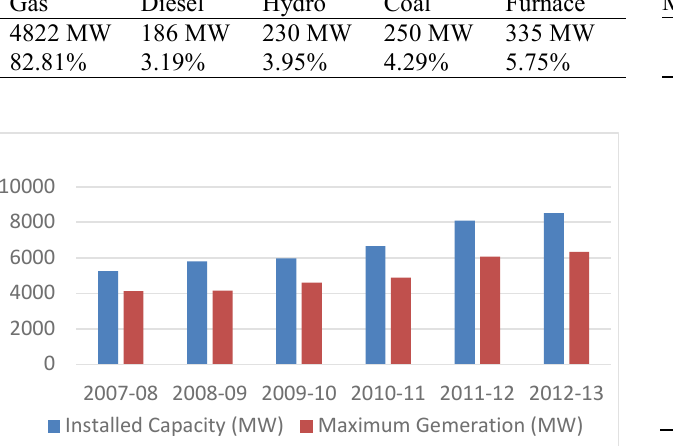
Figure 4: Installed Capacity and Generation